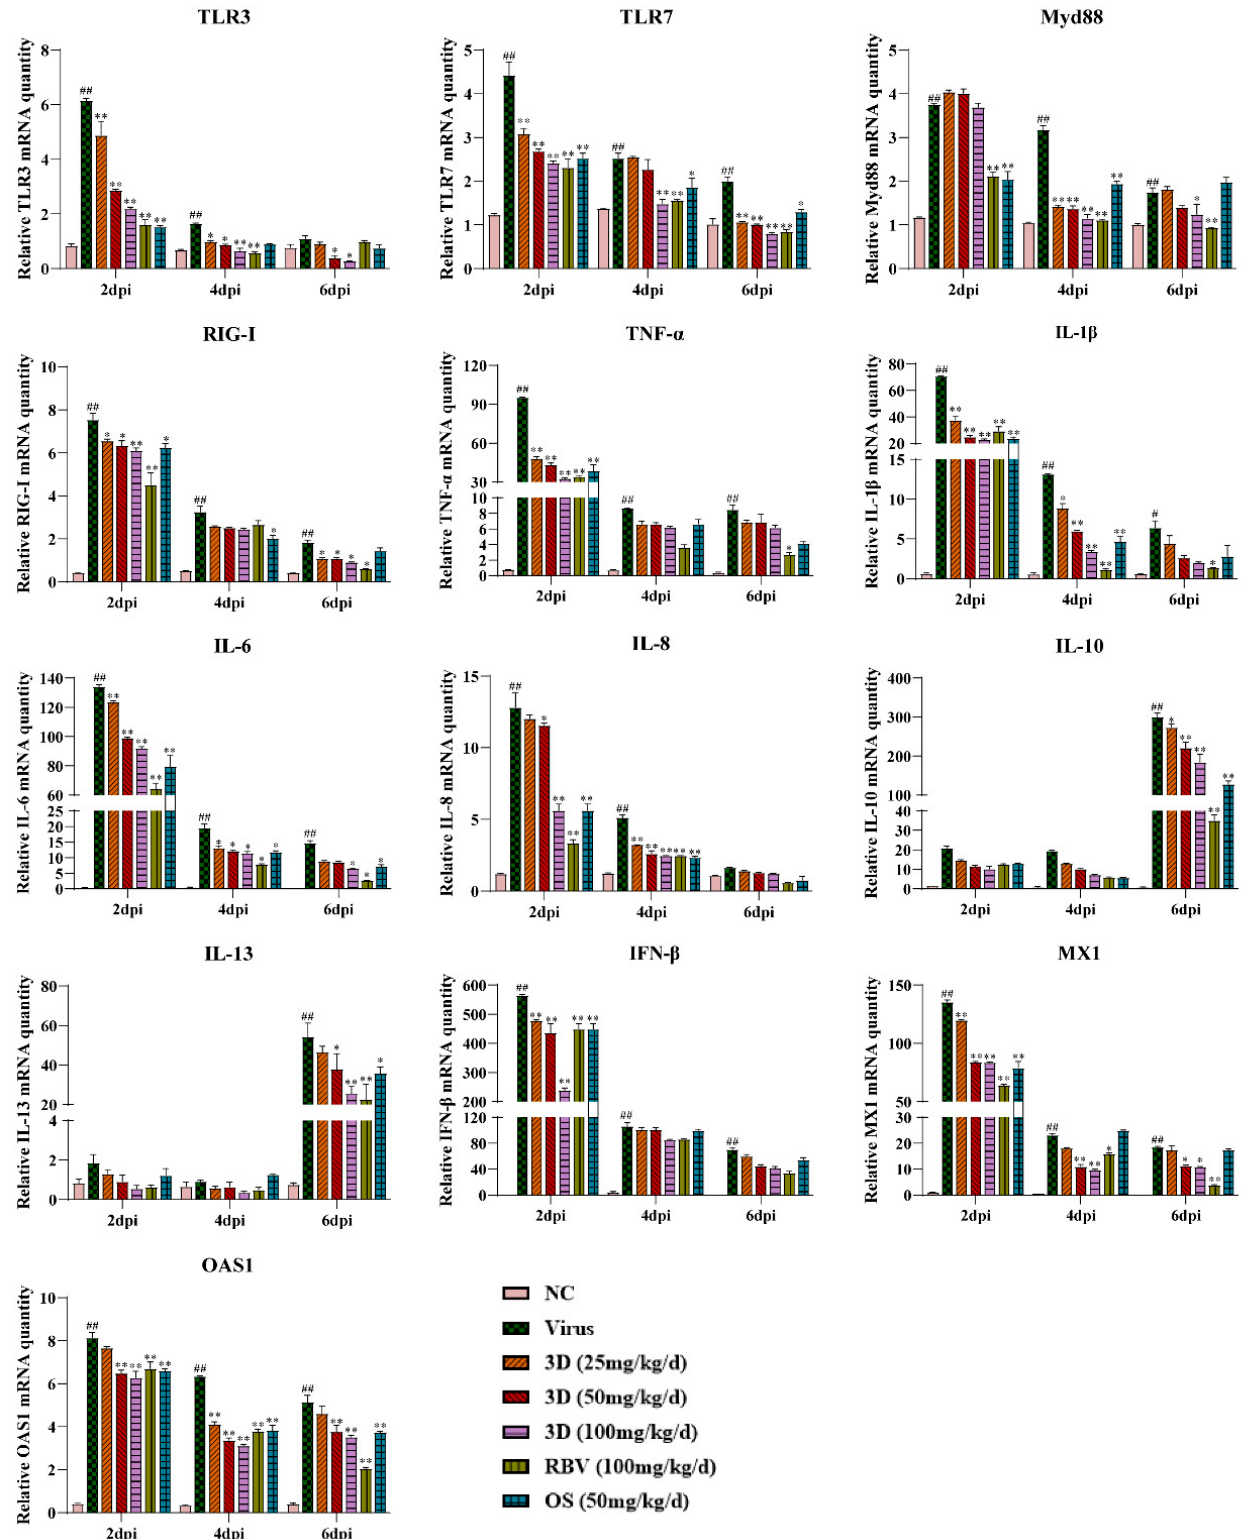
Figure 8. Effects of 3D on the expression of mediators related to RIG-I in vivo. At two, four, and six days post-infection, the mice were euthanized and RNA was isolated from lung tissues. The mRNA expression of the genes expressing indicated mediators in the lungs was determined using qRT-PCR. Data are shown as the mean ± SD. ( # p < 0.05, ## p < 0.01 compared with the normal control; * p < 0.05, ** p < 0.01 as compared with the virus control).